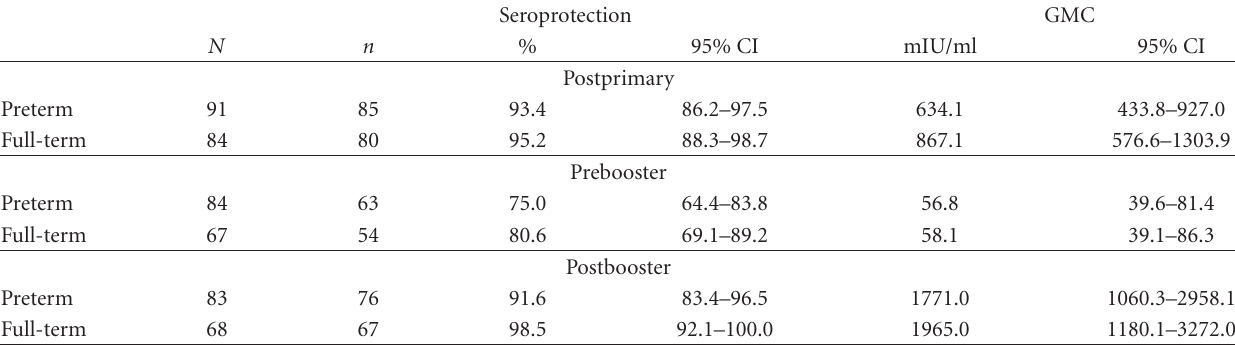
Table 1: Anti- HBs seroprotection rates and GMCs in preterm and full-term infants one month after the primary course and before and after the booster dose (ATP cohort for immunogenicity).